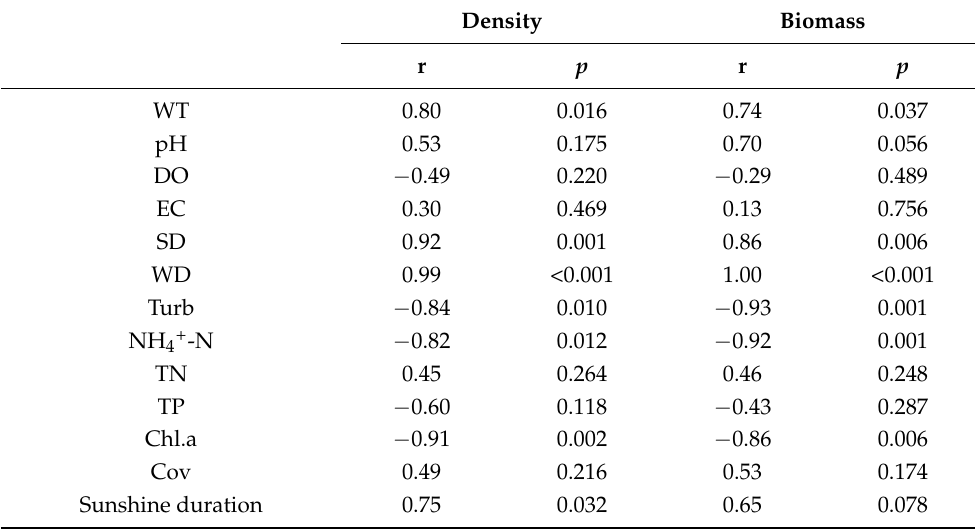
Table 3. Correlation analysis between zooplankton and environmental factors in the period of extreme water level fluctuation.